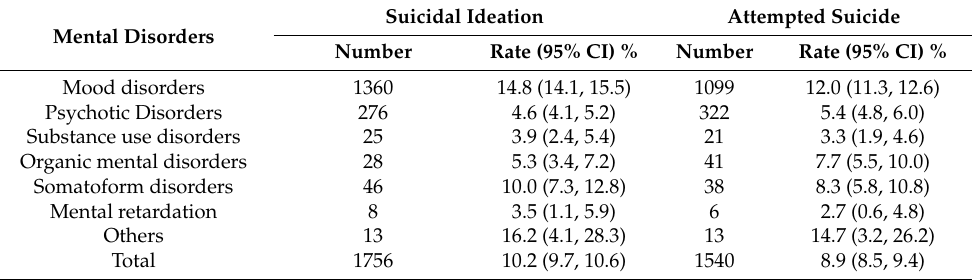
Table 3. The numbers and rates of suicidal ideation and attempted suicide for each category of mental